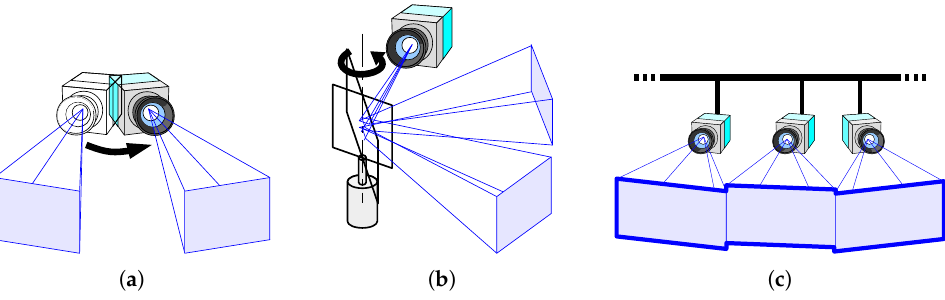
Figure 3. Approaches for expanding the field-of-view: ( a ) Mechanically turning the camera itself, ( b ) changing the gaze direction using a galvanometer mirror, and ( c ) networking multiple